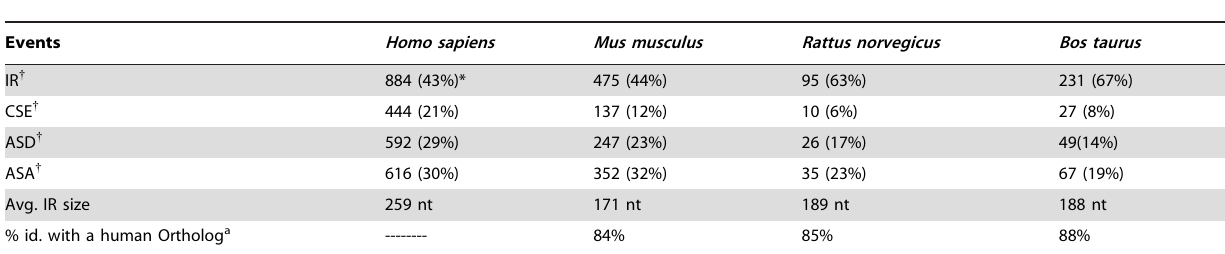
Table 3. Number of events per